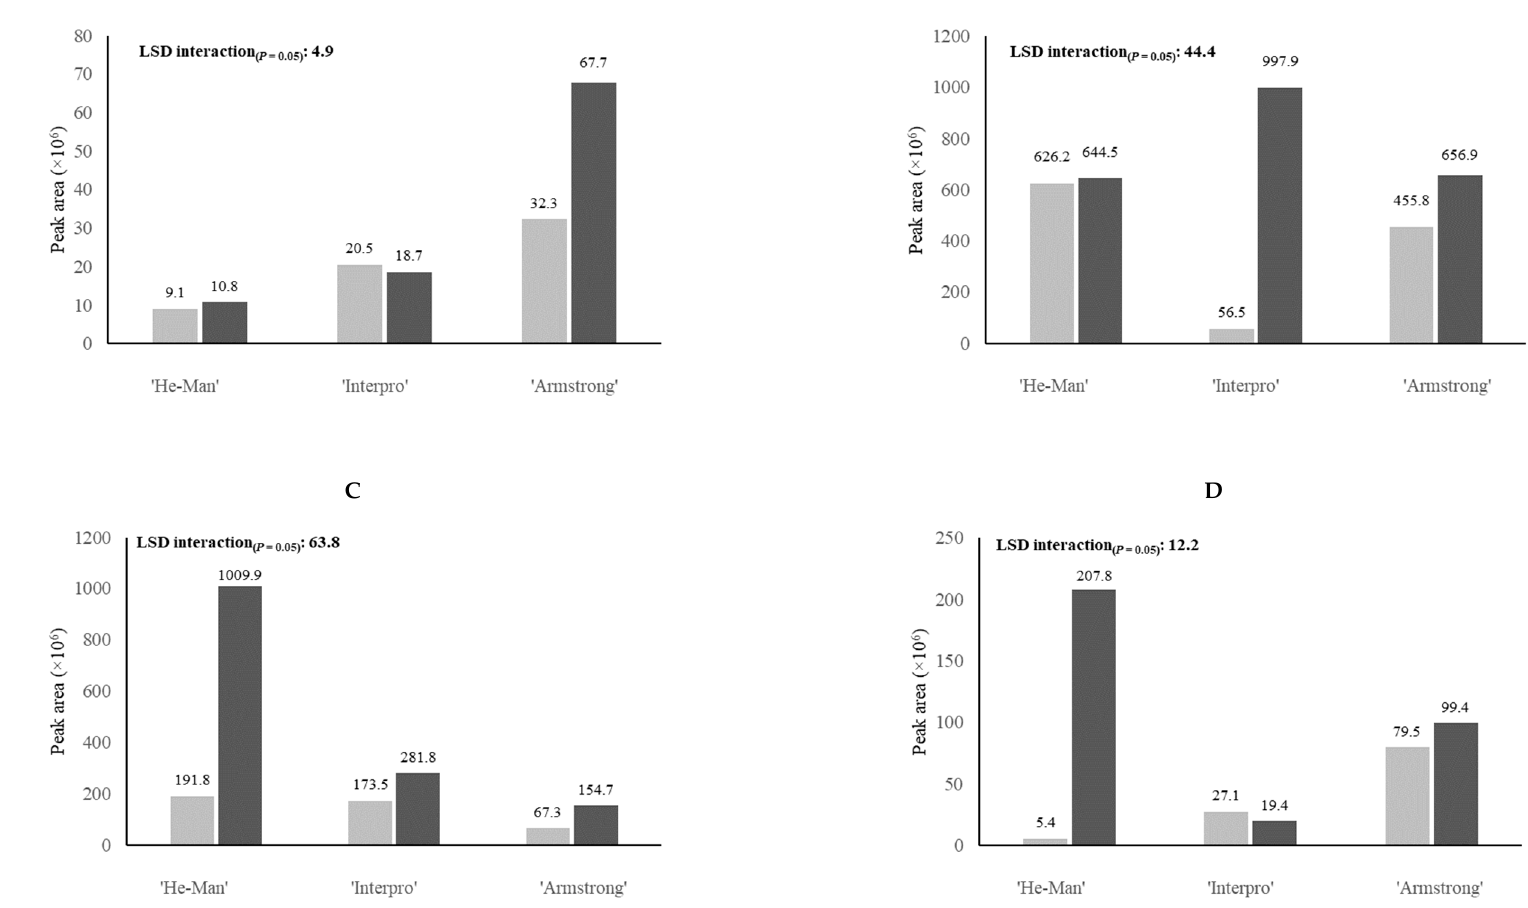
Figure 2. Peak area (×10 6 ) of 3-methylbutanal ( A ), hexanal ( B ), E-2-hexenal ( C ), and E-2-heptenal ( D ) in tomatoes “Sir Elyan” as affected by ‘rootstock x ripening stage’ interaction. Light bars: S 1 . Dark bars: S 2 .